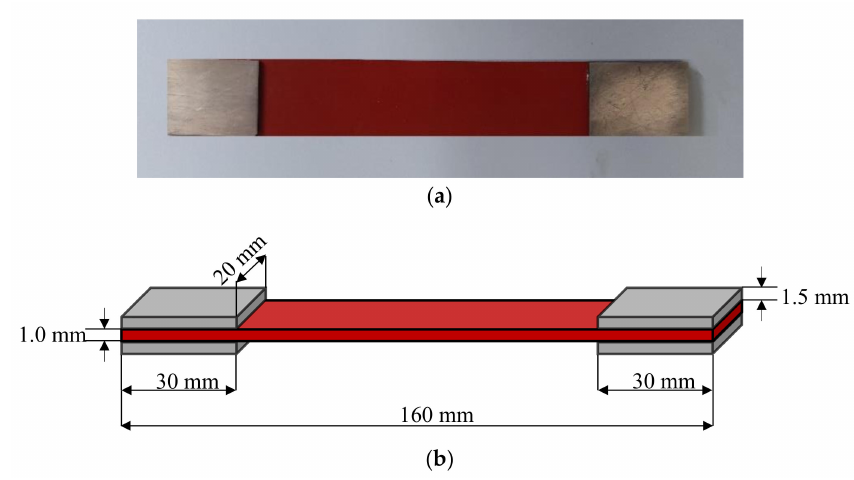
Figure 2. The specimen and its geometry employed in a uniaxial tensile test: ( a ) The image of silicone rubber specimen with bonded aluminum sheets; ( b ) The dimensions of silicone rubber specimen and aluminum sheets.